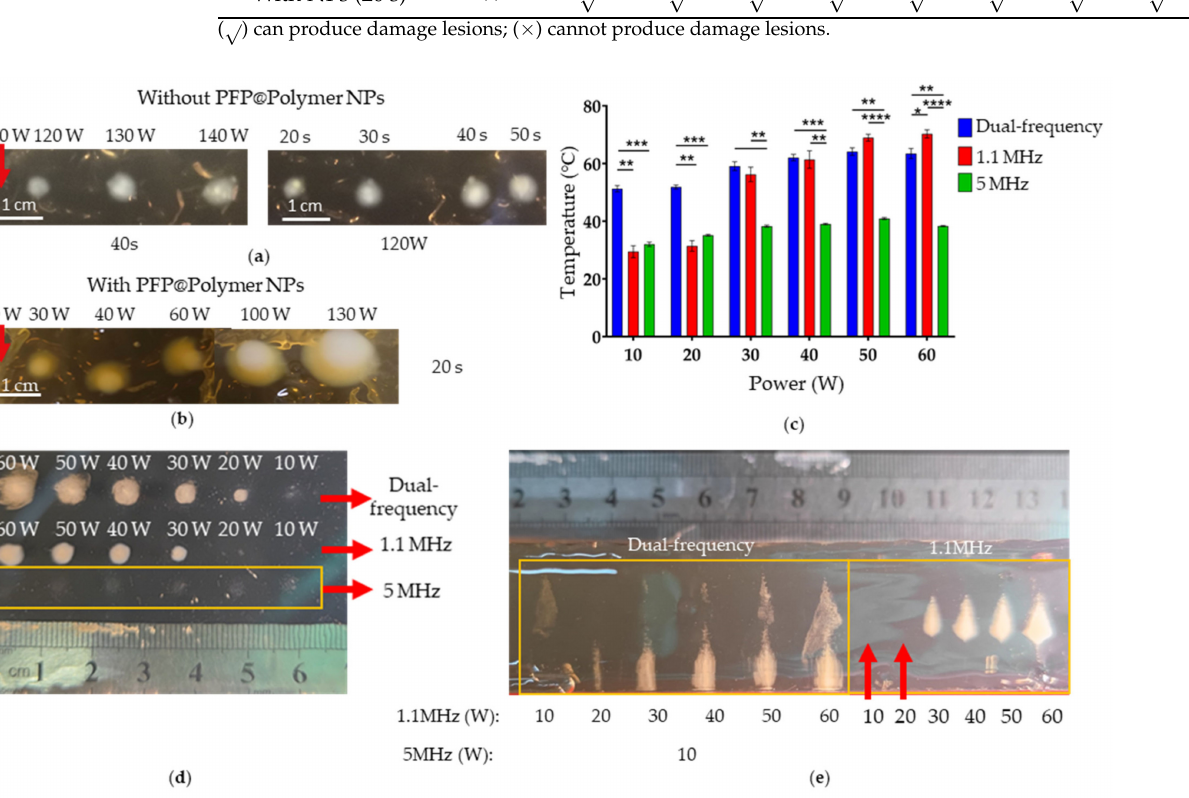
Figure 3. The enhanced performance of PFP@Polymer NPs and dual-frequency HIFU in the treatment in vitro. The damage effect without ( a ) and with ( b ) PFP@Polymer NPs in a BSA–polyacrylamide gel phantom under single-frequency 1.1 MHz HIFU irradiation (power of single-frequency 1.1 MHz HIFU: 20 140 W; intervals of 10 W. Irradiation time 20 s, 30 s, 40 s, and 50 s). ( c ) The temperature rise after single-frequency (1.1 or 5 MHz) and dual-frequency HIFU irradiation (power: 10 – 60 W; intervals of 10 W. Irradiation time: 20 s). When irradiated by dual-frequency HIFU, only the 1.1 MHz HIFU power is changed, and the 5 MHz HIFU power is fixed at 10 W. The water temperature is 25 ◦ C. ( d ) The damage effect